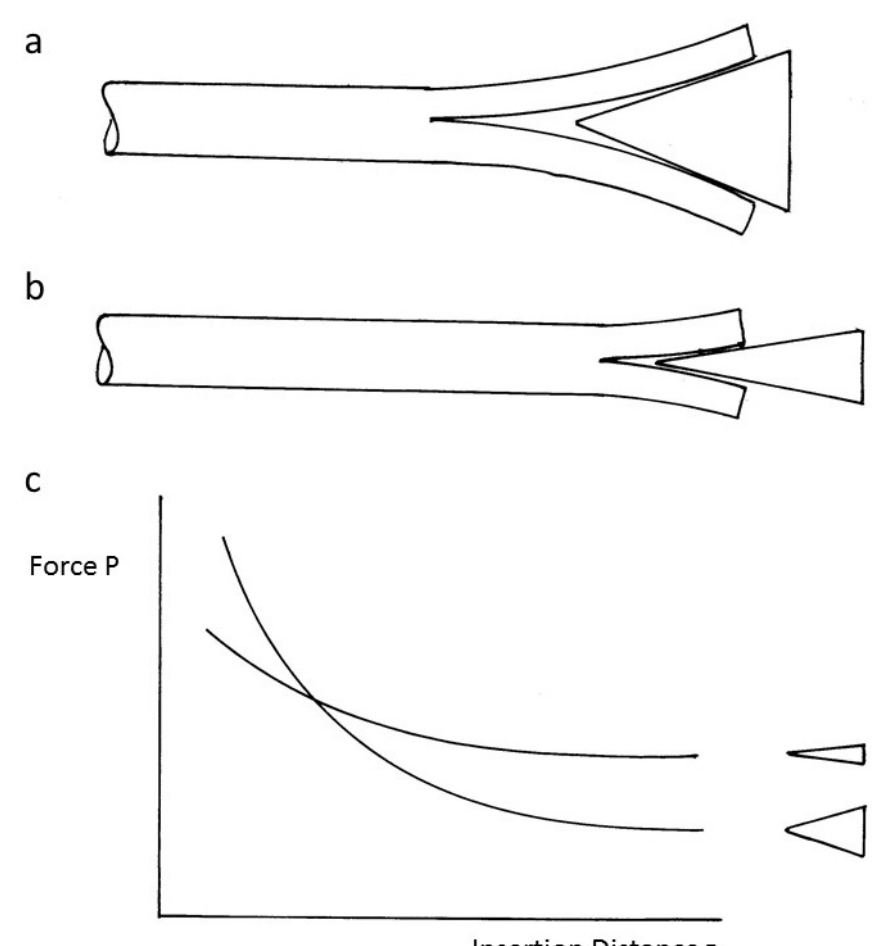
Figure 4. Splitting of a coppice pole by a) a wide angle and b) a low angle wedge. Initially force is higher for the broad wedge because the crack opens further, but it falls to a lower level because the friction drops as the wedge touches the wood further from the crack tip, encountering less